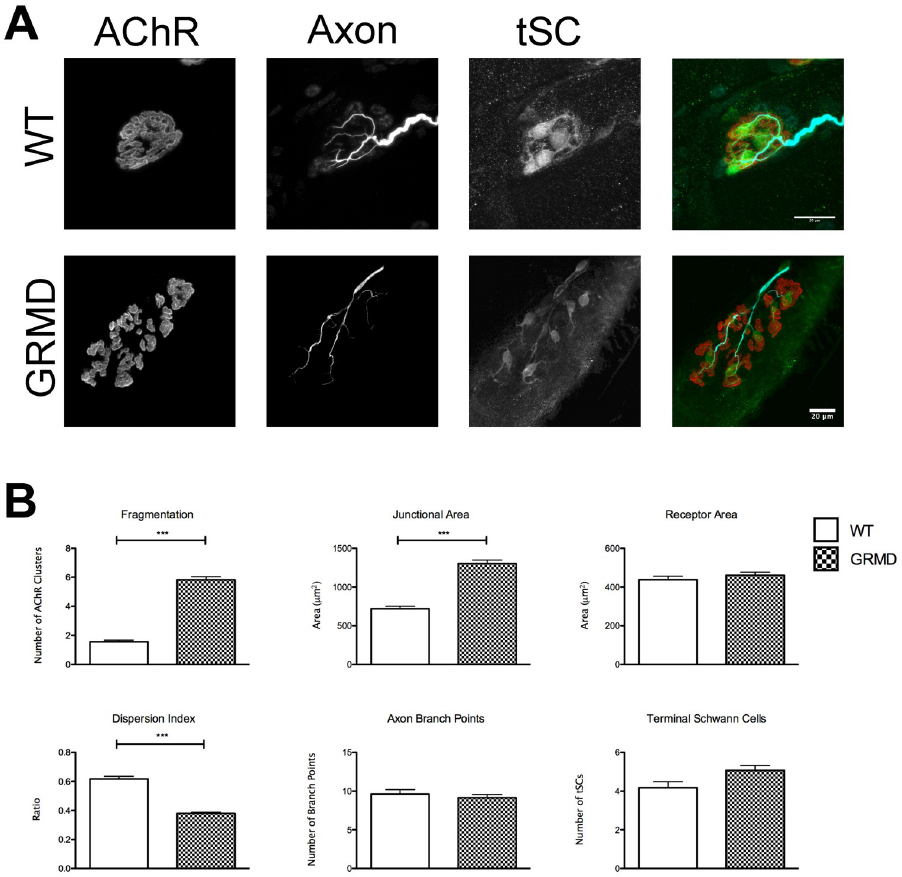
Fig 2. GRMD NMJ morphology. (A) Confocal maximum intensity projection of adult WT and GRMD NMJs harvested from the cranial tibial muscle. Composite images pseudocolored red-AChR, cyan-motor axon, green-tSC. Scale bar = 20 μ m. Note the difference in magnification between WT and GRMD. (B) Junctional measurements in WT and GRMD NMJs as described in “Image acquisition and analysis”. Asterisks denote significant differences (t-test, P < 0.0001). Exact n can be found in text as t(df) = t-value. n = df + 2. n is number of pooled individual NMJs compared.